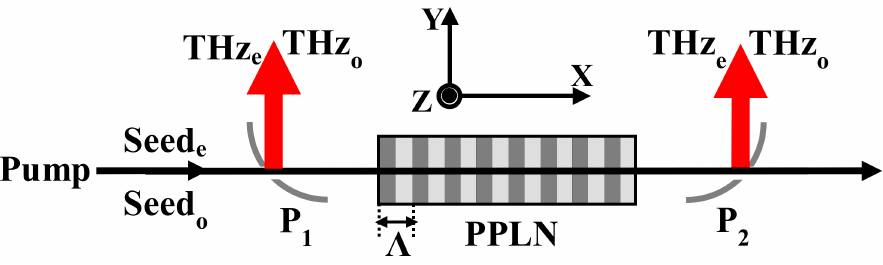
Figure 1. Schematic diagram of terahertz (THz) wave generation by stimulated polariton scattering (SPS) processes in a periodically poled LiNbO 3 (PPLN) crystal with a quasi-phase-matching (QPM) condition. Λ is the poling period of the PPLN crystal. P 1 and P 2 are parabolic mirrors which transmit the pump and two seed waves, and couple out the two THz